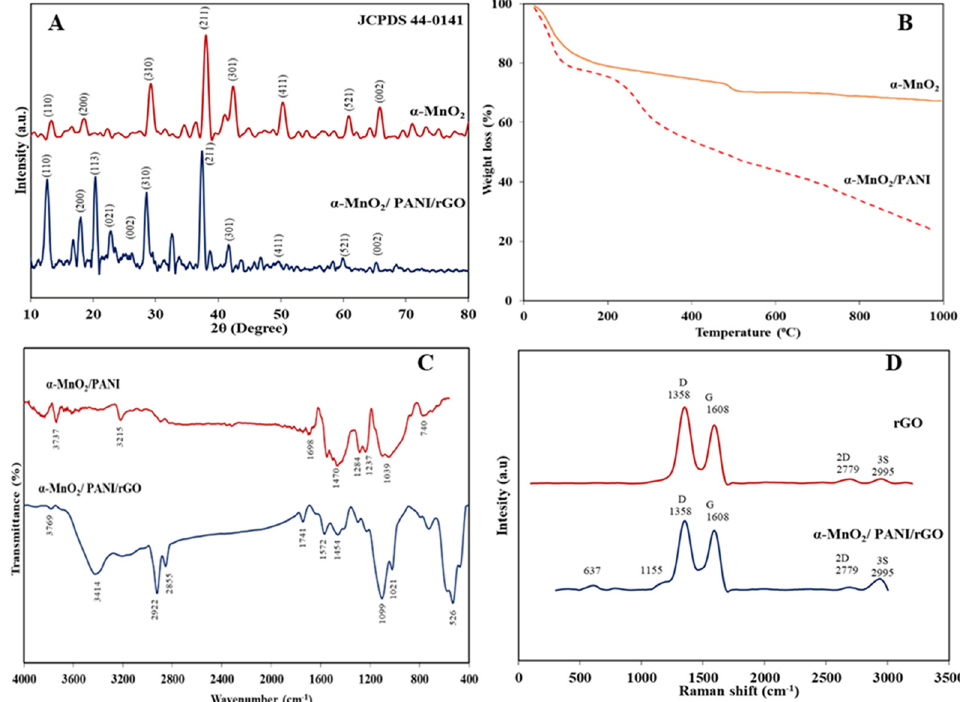
Figure 1. ( A ) XRD pa tt erns of α -MnO 2 and α -MnO 2 /PANI/rGO, ( B ) TGA curves of MnO 2 and MnO 2 -PANI samples, ( C ) FTIR spectra of α -MnO 2 -PANI and α -MnO 2 /PANI/rGO, ( D ) Raman spectra of rGO and α -MnO 2 /PANI/rGO sample.